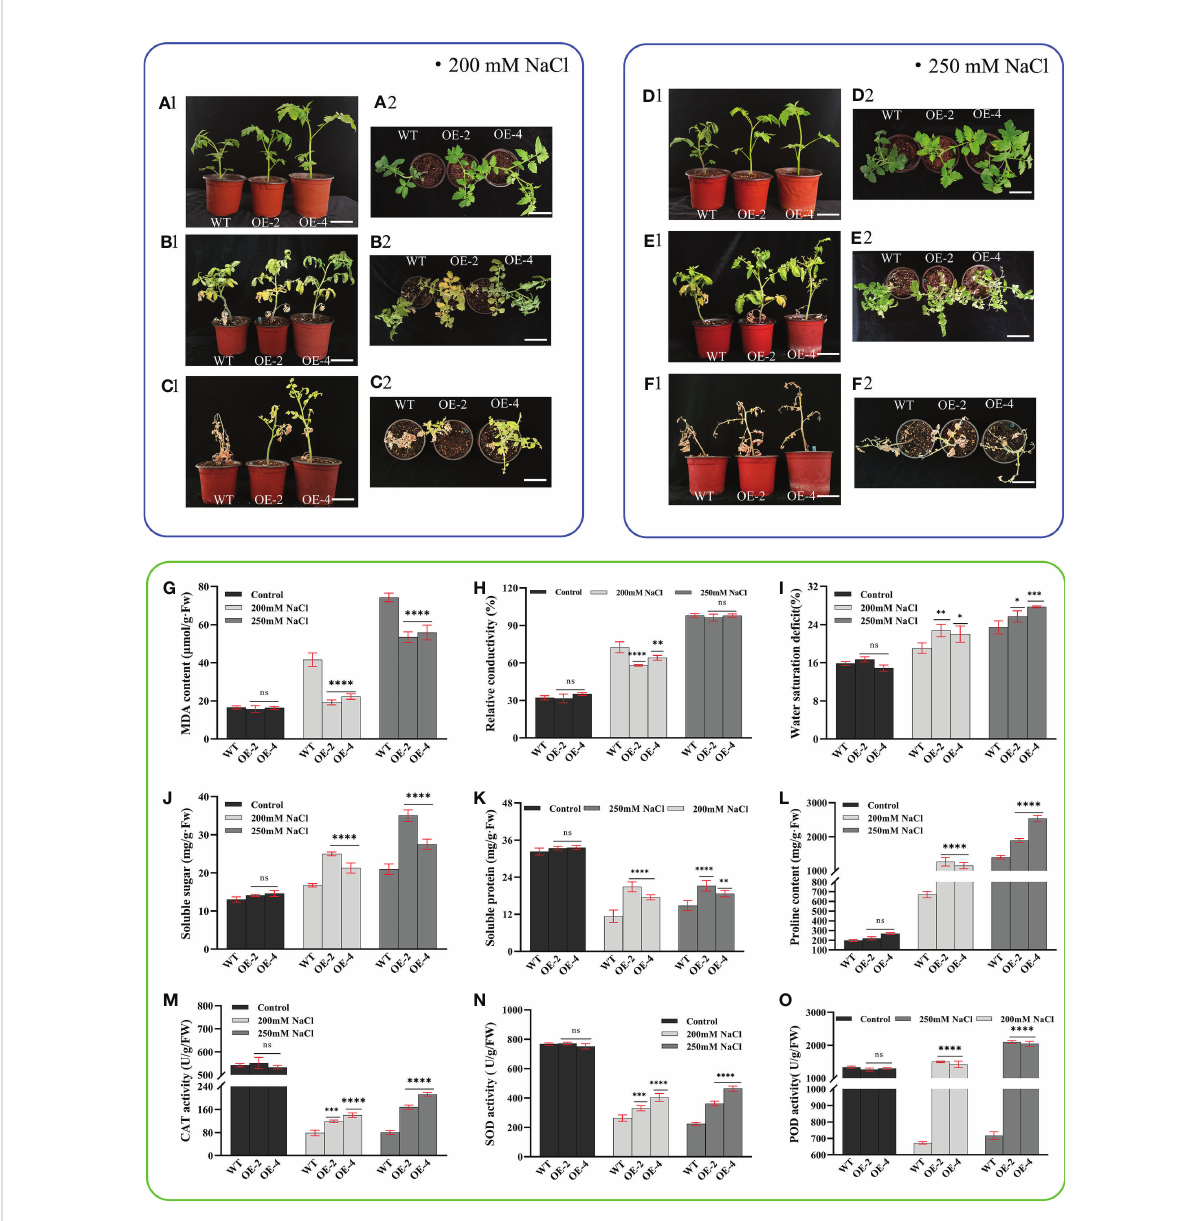
FIGURE 4 Phenotypic and physiological data of wild-type and transgenic tomatoes under NaCl stress (200mM NaCl and 250mM NaCl). (A1) (Main view) and (A2) (Top view): The growth status of wild-type and transgenic tomato at 4 weeks of age under normal watering. (B1) (Main view) and (B2) (Top view): Wild-type and transgenic tomato growth status after 14 days of 200 mM NaCl treatment. (C1) (Main view) and (C2) (Top view): The growth status of B1 or B2 after 7 days of normal watering. (D1) (Main view) and (D2) (Top view): The growth status of wild-type and transgenic tomato at 4 weeks of age under normal watering. (E1) (Main view) and (E2) (Top view): Wild-type and transgenic tomato growth status after 14 days of 200 mM NaCl treatment. (F1) (Main view) and (F2) (Top view): The growth status of E1 or E2 after 7 days of normal watering. (G) MDA content. (H) Relative conductivity content. (I) Water saturation de fi cit. (J) Soluble sugar content. (K) soluble protein content. (L) Proline content. (M) CAT activity. (N) SOD activity. (O) POD activity. Data are means ± SD of three replicates. (7.2 cm inner diameter, 11.5 cm high). (Ns >